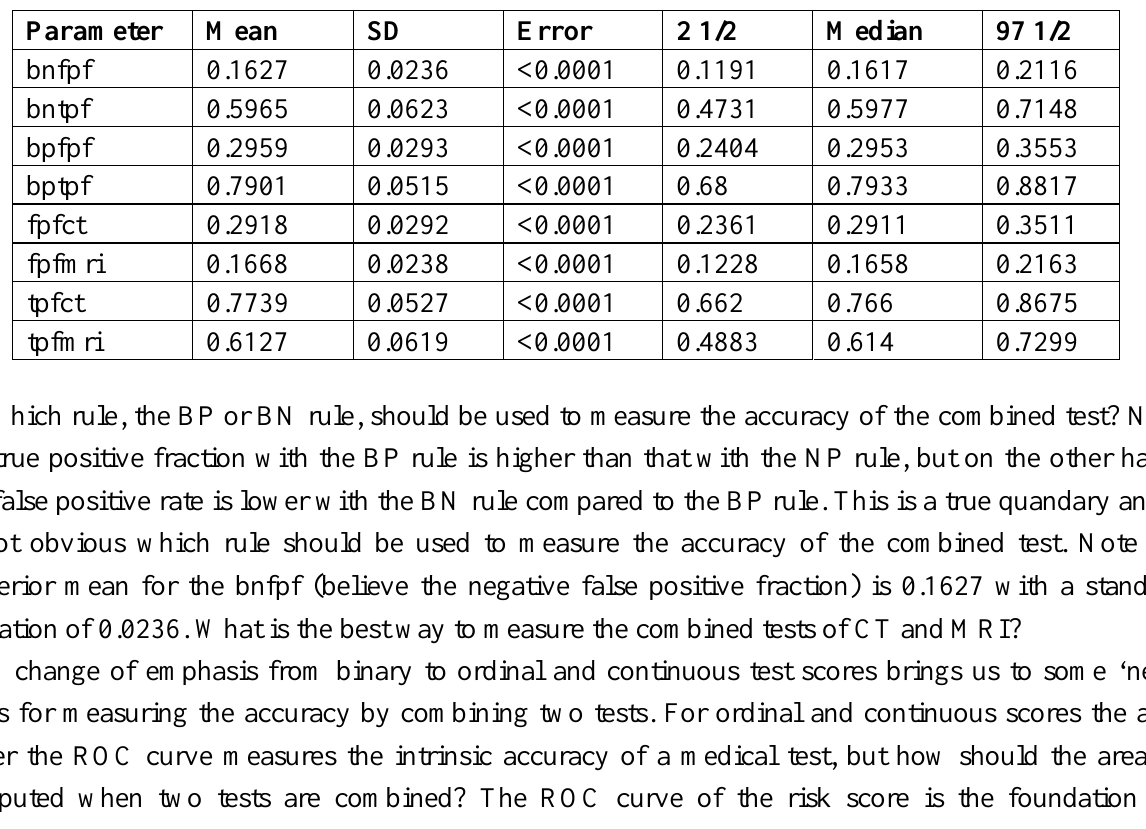
Table 25. Bayesian analysis for combined test of CT and